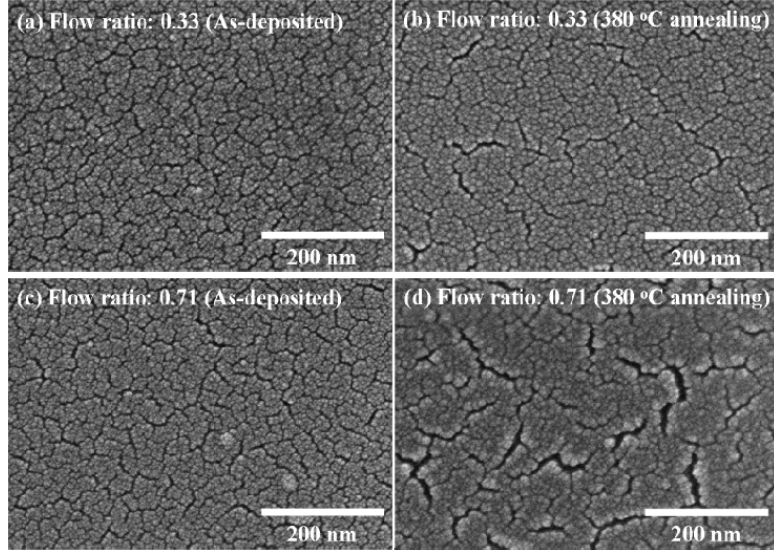
Figure 2. FE-SEM micrographs of the SnO 2 − x thin films prepared at various flow ratios and a working pressure of 4 × 10 − 2 Pa. The flow ratio of 0.33 of O 2 /(O 2 + Ar) ( a ) for as-deposited films; ( b ) 380 °C annealing and the flow ratio of 0.71 of O 2 /(O 2 + Ar) ( c ) for as-deposited films; ( d ) 380 °C annealing.